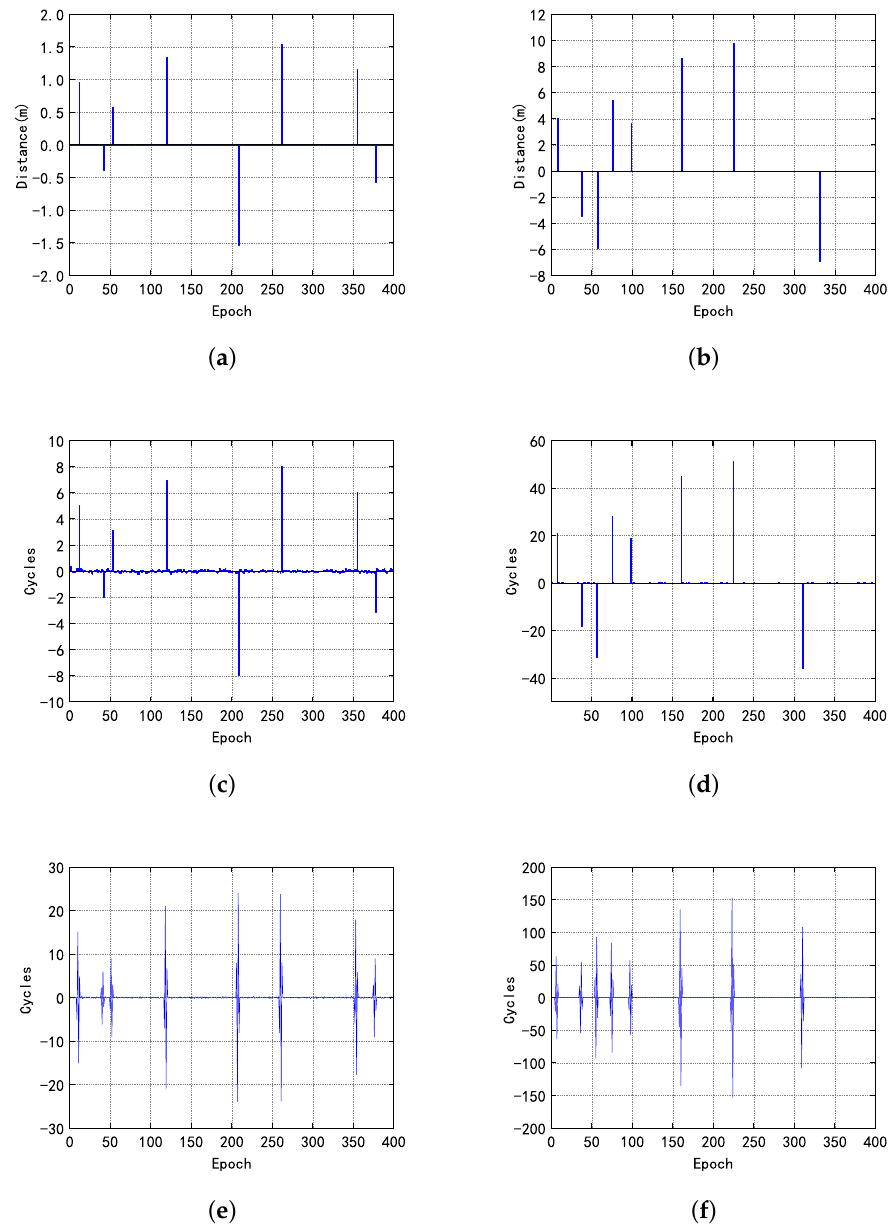
Figure 7. The second case, the three columns on the left, the results obtained by three different methods, ( a ) proposed indoor dual-frequency cycle slip detection method; ( b ) the proposed indoor dual-frequency cycle slip detection method; ( c ) Doppler method; ( d ) Doppler method; ( e ) high-order difference method in the third case, the three columns on the right,the results obtained by three different methods; ( f ) high-order difference